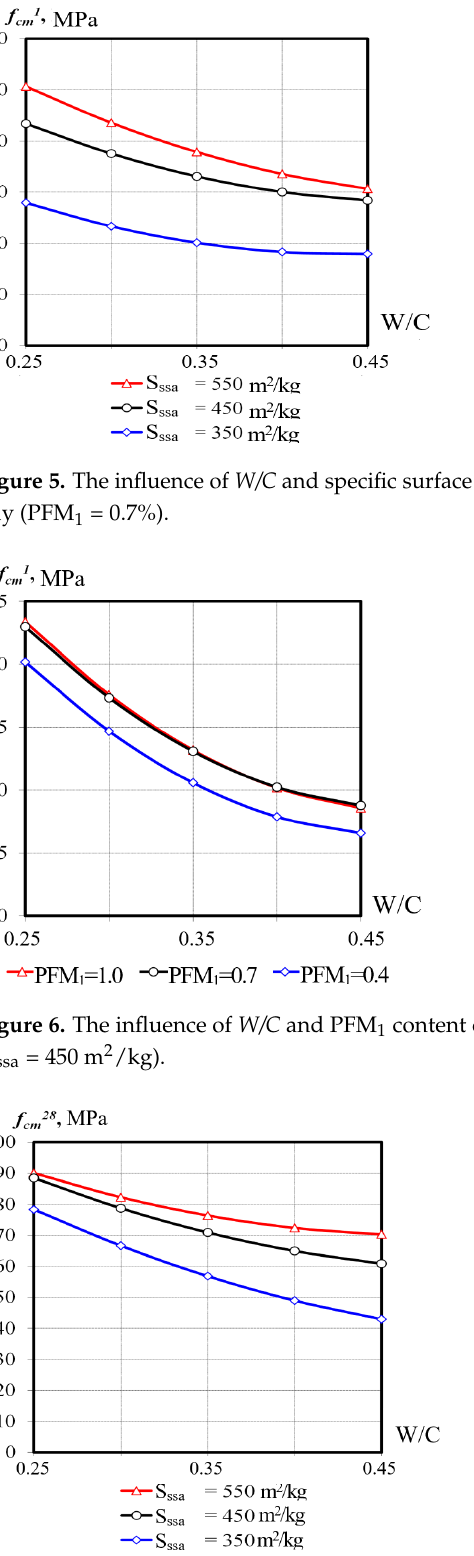
Figure 7. The influence of W/C and specific surface area on the concrete compressive strength at 28 days (PFM 1 = 0.7).